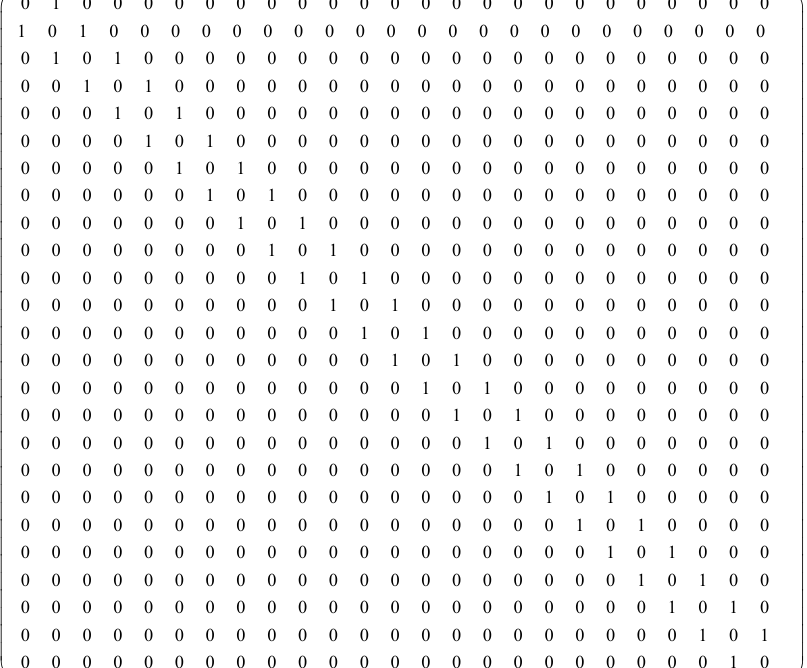
Figure 1. Adjacency matrix of a bus station network.